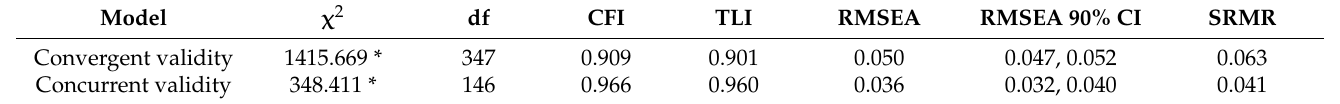
Table 3. Models to study the validity of the Flourishing Scale.